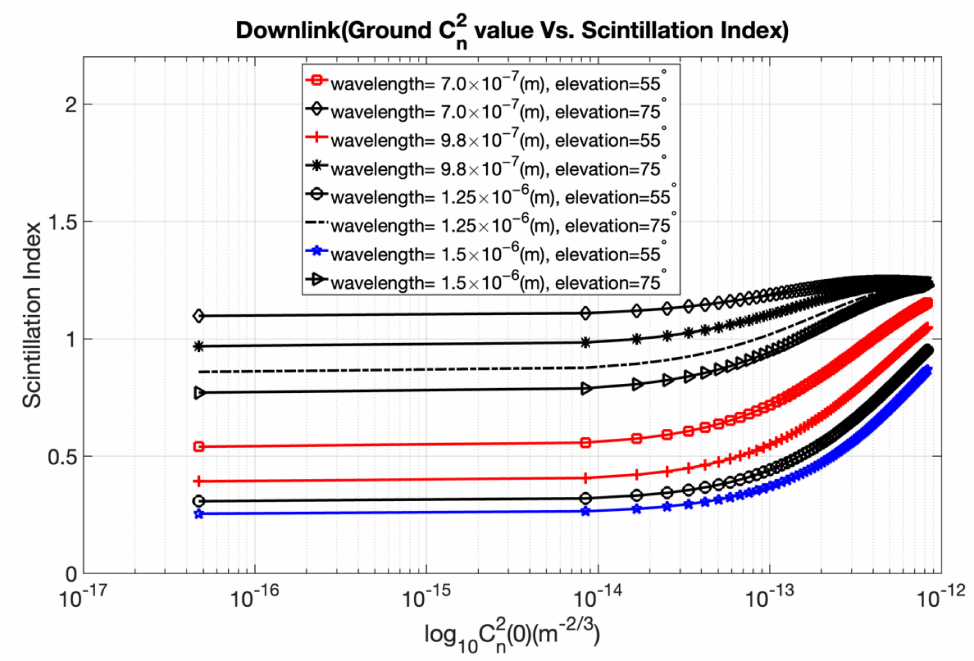
Figure 7. Variation in the scintillation index in a downlink